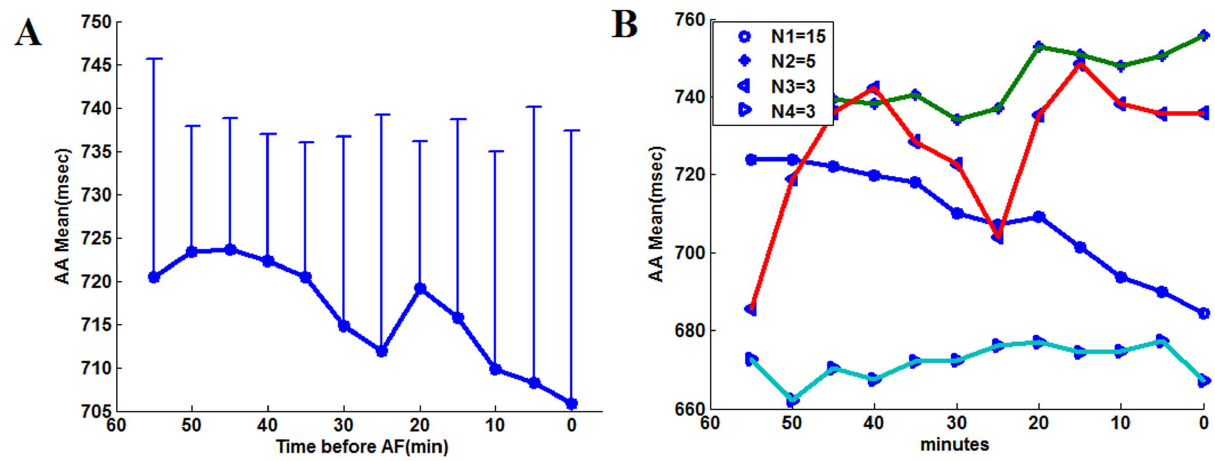
Figure 6. Temporal evolution and patter of changes of AAMean A: The trend of mean value of variables AAMean . B: Profiles obtained by cluster analysis.